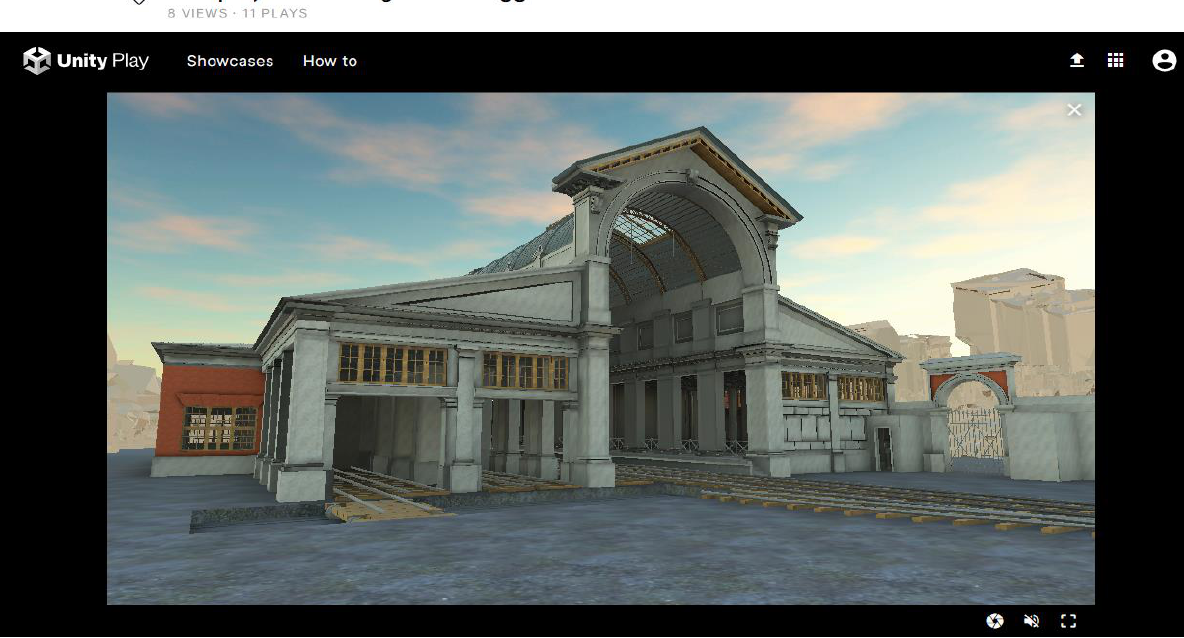
Figure 10. Screenshot taken from the online